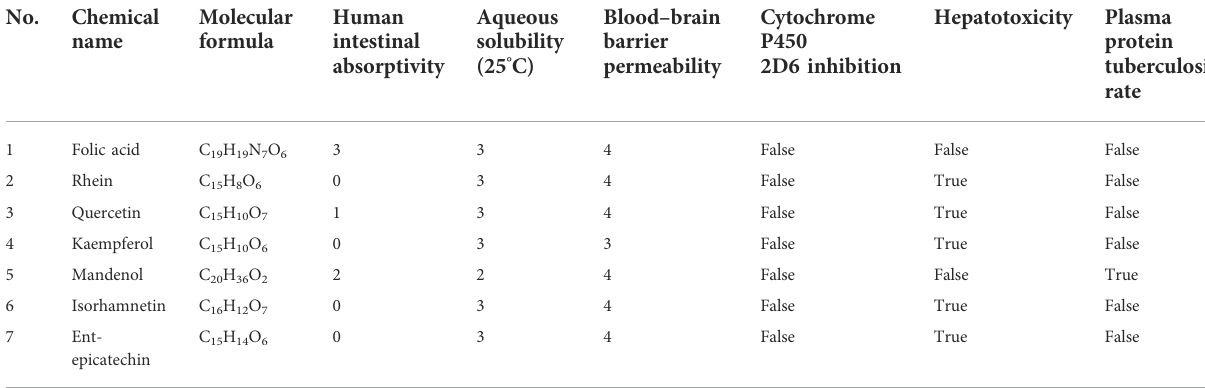
TABLE 4 Results of ADMET screening.